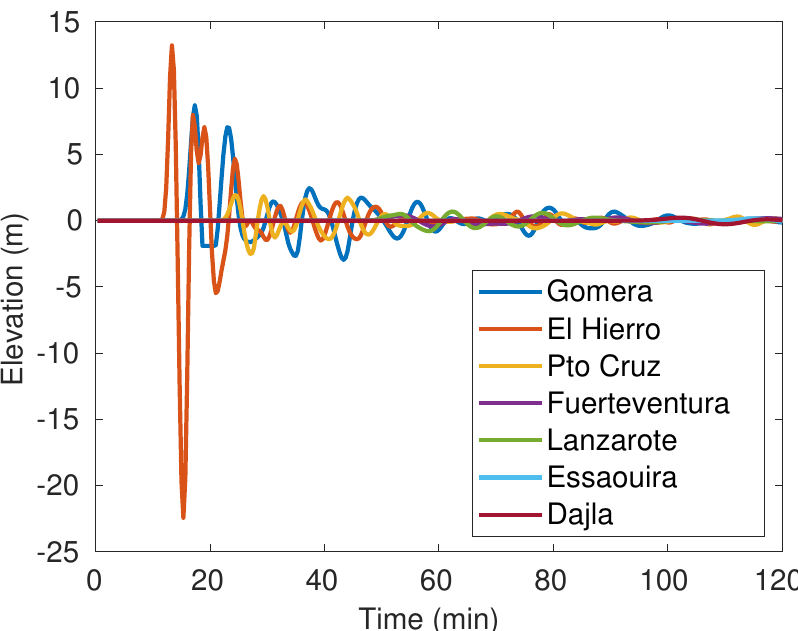
Figure 5. Time series of water surface elevations at selected points (Figure 1) for a 4.5 km 3 slide down the island slope.